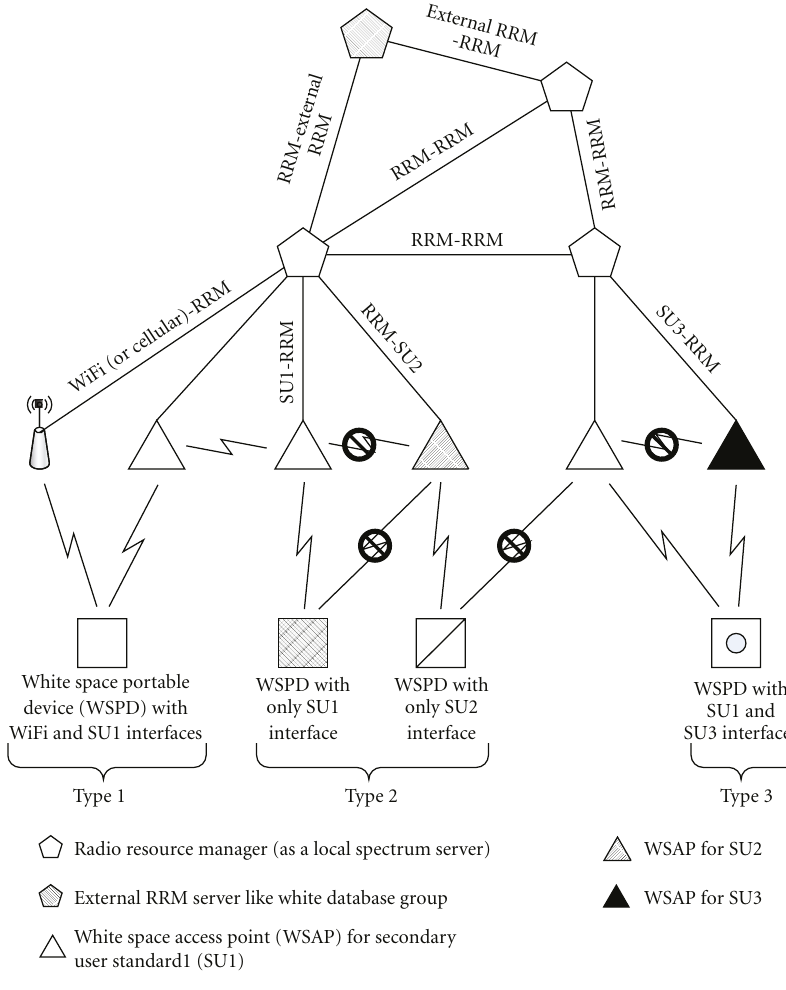
Figure 1: A network reference model for dynamic spectrum map